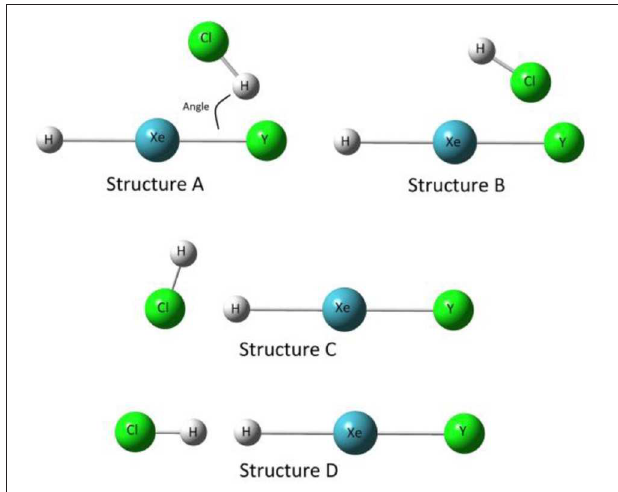
FIGURE 1 | Four structures of complexes HXeY ··· HCl (Y = Cl, Br,